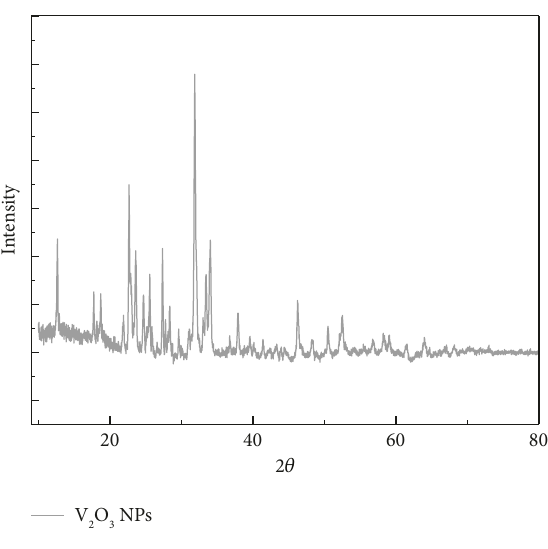
Figure 14: XRD pattern of Cr